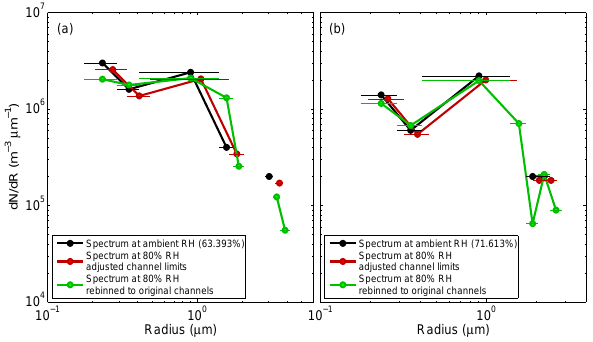
Fig. 2. Two examples of a relative humidity correction applied to sea-spray aerosol spectra recorded at 10Hz. The black lines show the original spectra at ambient humidity, the red lines show these spectra corrected to 80% relative humidity, and the green lines these corrected spectra after re-binning to the original instrument chan-